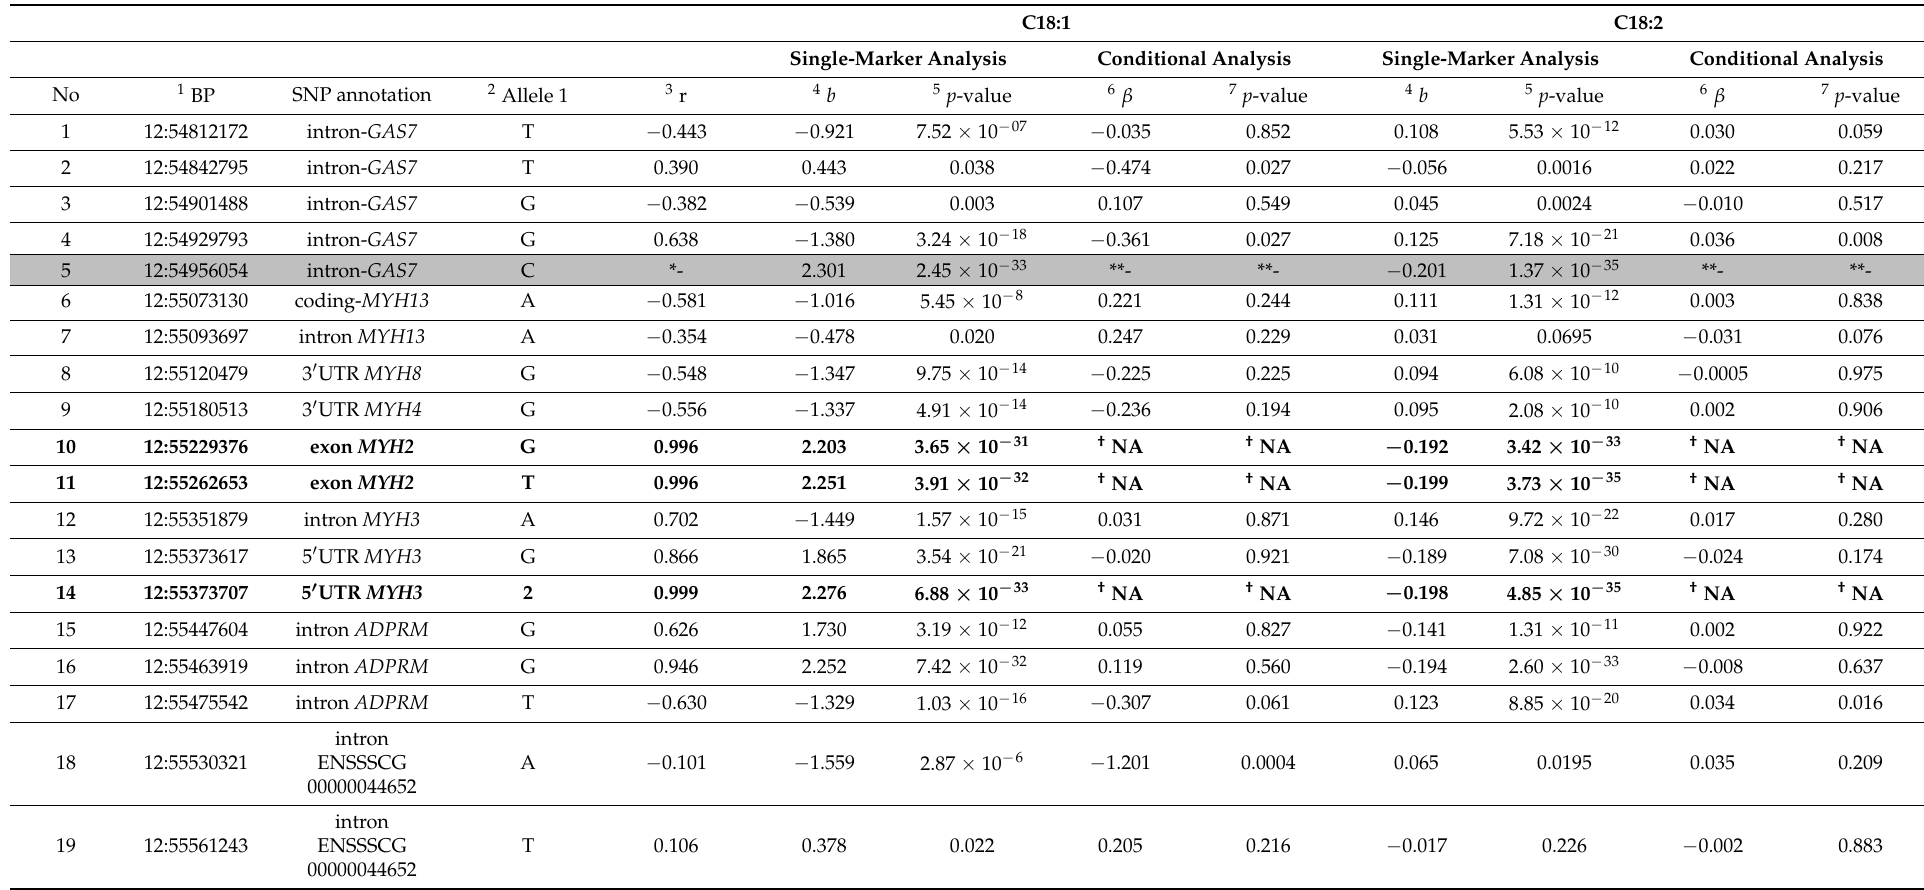
Table 3. Results of conditional association analyses for C18:1 and C18:2 using SNP markers in the 749.1 kb critical region in